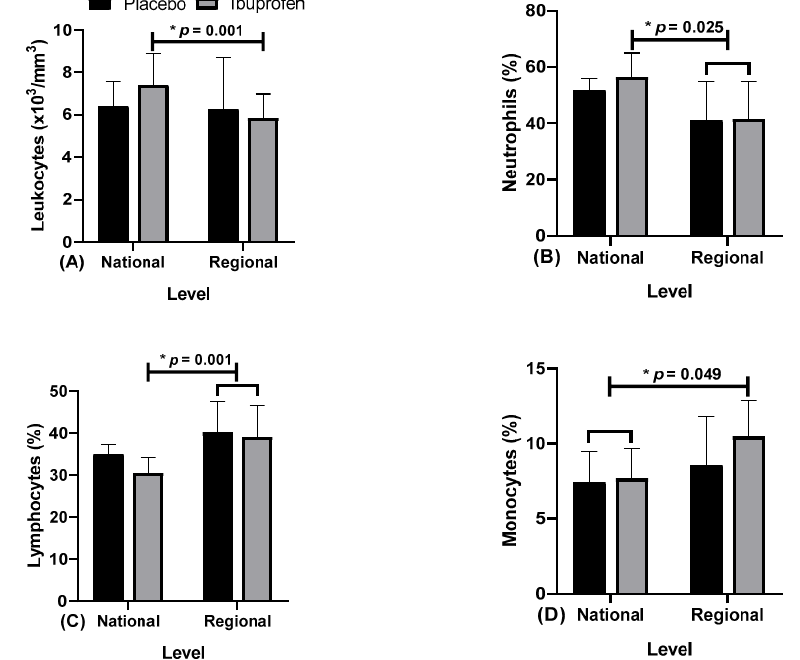
Figure 5. Blood markers: ( A ) leukocytes; ( B ) neutrophils; ( C ) lymphocytes; and ( D ) monocytes; with the use of placebo (PLA) and ibuprofen (IBU) at the regional and national levels of training. * p < 0.005.